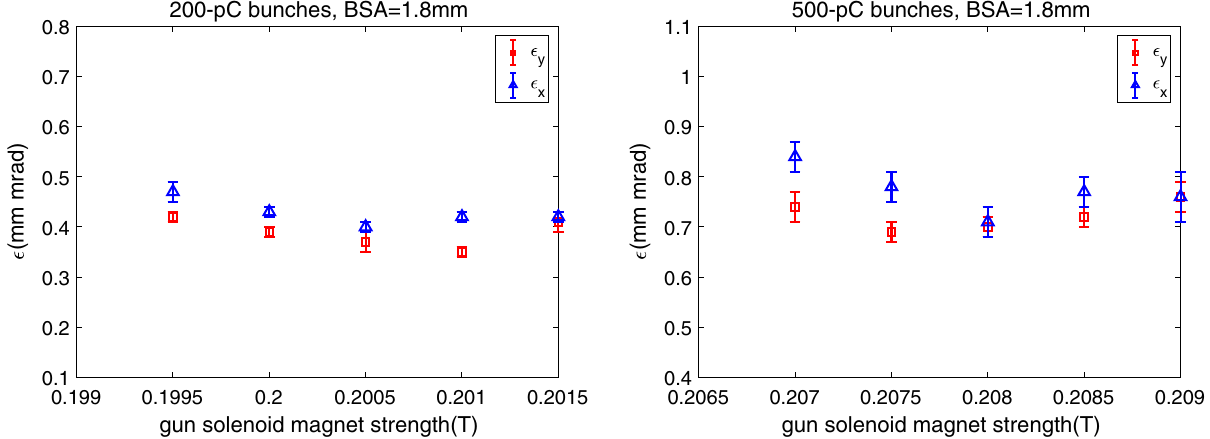
FIG. 10. Horizontal and vertical emittance of 200-pC and 500-pC bunches with a 1.8 mm diameter BSA.